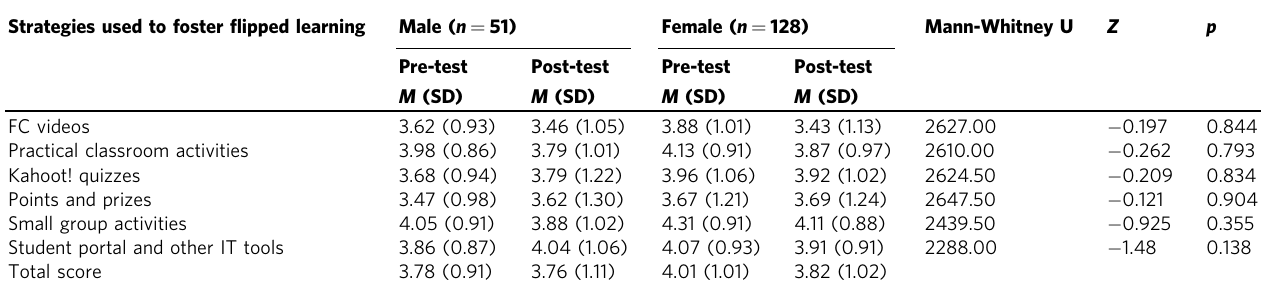
Table 7 Non-parametric results for the variables referring to the evaluation of the strategies used to foster their learning in this approach during the COVID-19 pandemic according to the gender of the